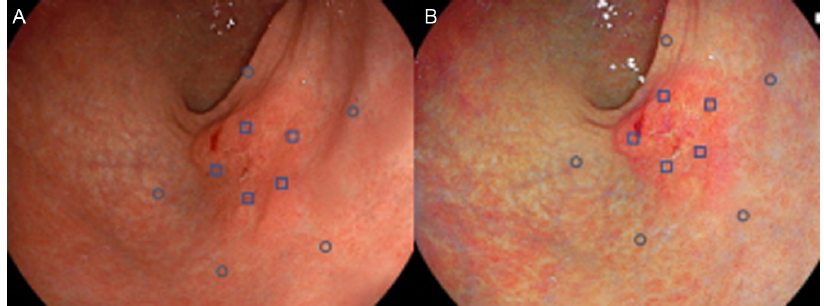
Figure 2. Analysis of color difference using the International Commission on Illumination 1976 color space. Five points were randomly selected from the cancerous lesion and nearby mucosa in white light imaging (A) and linked color imaging (B), respectively. The L * a * b * values of both cancerous lesion and surrounding mucosa were calculated based on the mean RGB values, and the color difference (Δ E ) was calculated based on Δ L , Δ a , and Δ b using the formula ( (cid:31) E 2 ). L * is defined as lightness, a * is the red–green component, and b * is the yellow–blue component. RGB, red, green, and